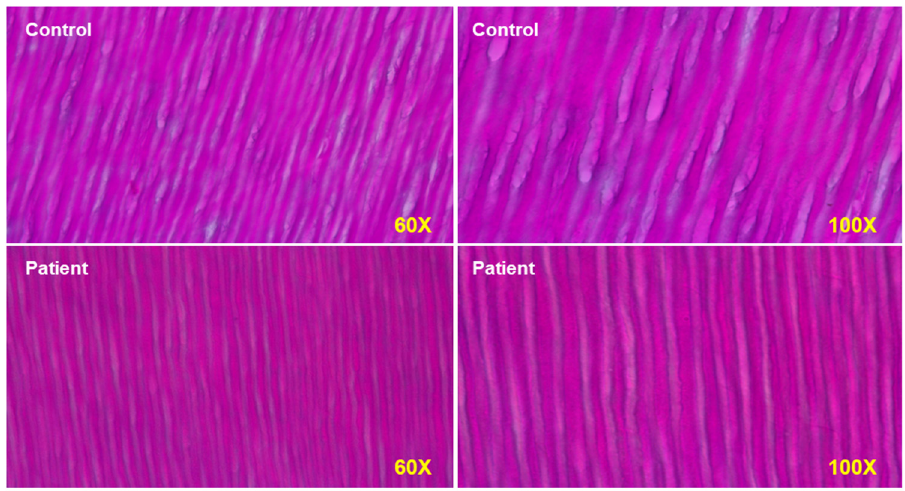
Figure 4. PAPP-A2 null patient has narrower dentin tubules at seen at magnifications of 60 × and 100 × . Both odontoblasts and amyloblasts have impaired function in the